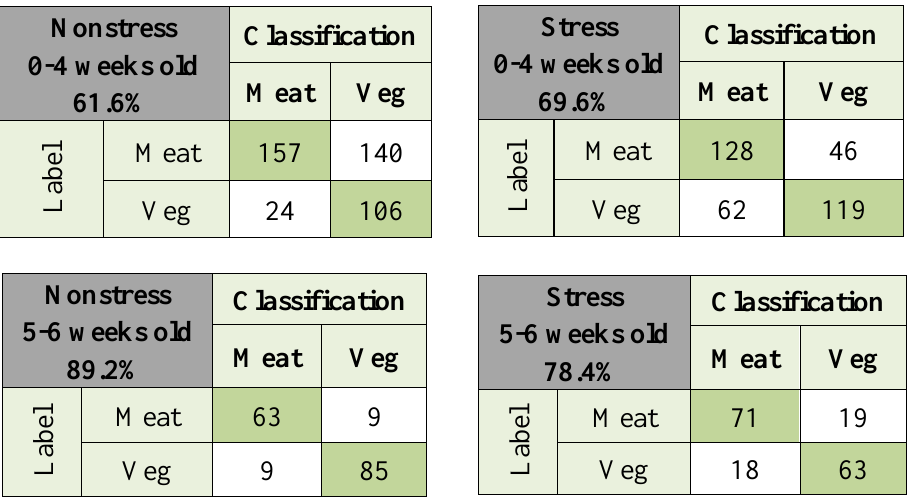
Table 9. Meat vs . Vegetarian diet classification as a function of age and stress